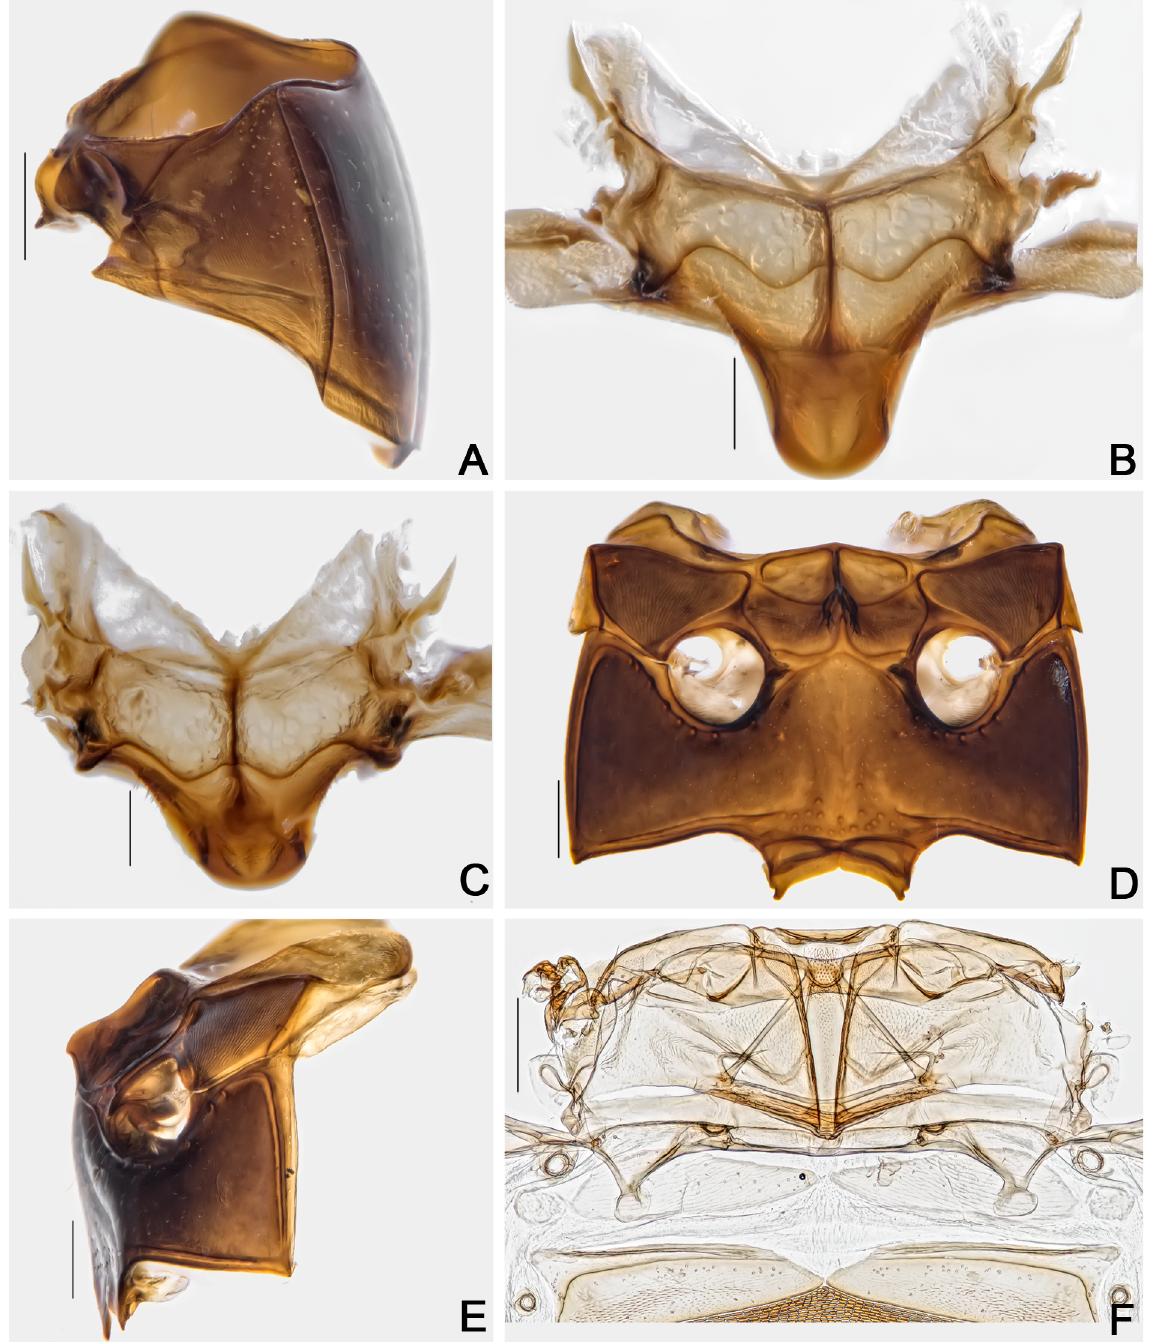
Fig. 17. Cyparium lescheni sp. nov., paratypes, ♂ (CELC). A . Prothorax, lateral view B–C . Scutellar plate. B . Dorsal view. C . Apically slanted view. D–E . Meso- and metathorax. D . Ventral view. E . Lateral view. F . Metanotum. Specimens collected at Mata do Paraíso, Viçosa (A–E) and Mata da Biologia (F), Viçosa (MG, Brazil). Scale bars: A, D–F = 0.2 mm; B–C = 0.1